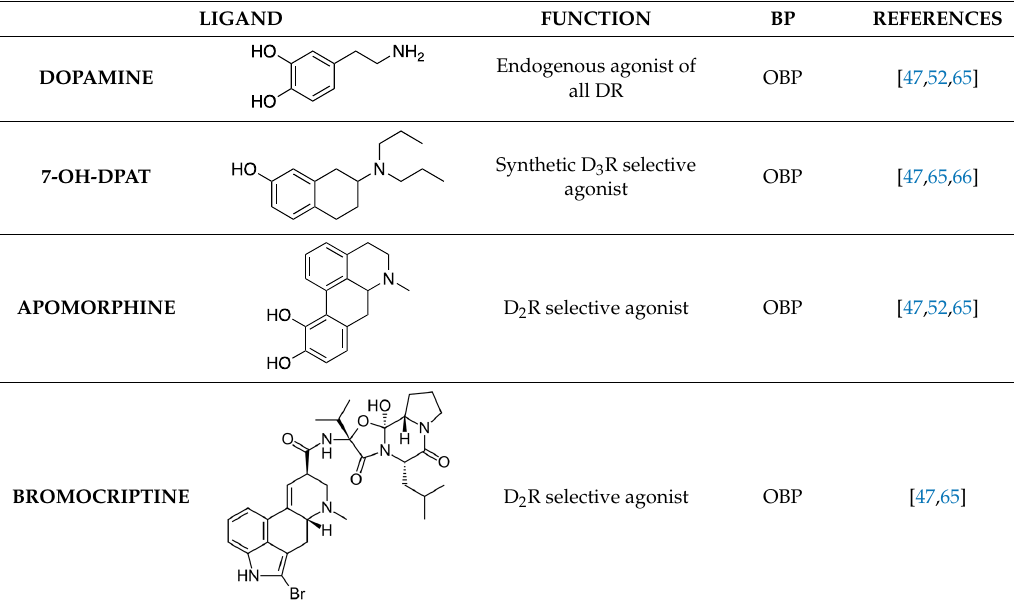
Table 1. Ligands used for molecular docking and information on their function.